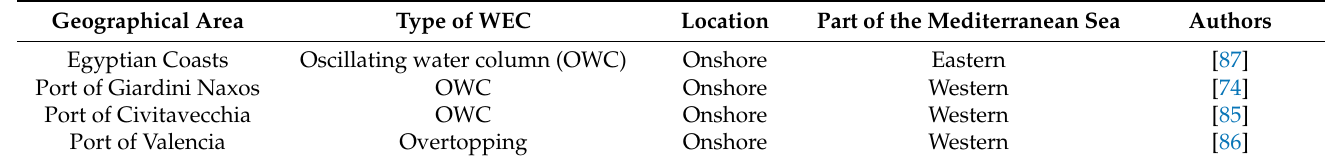
Table 6. Academic research on particular types of